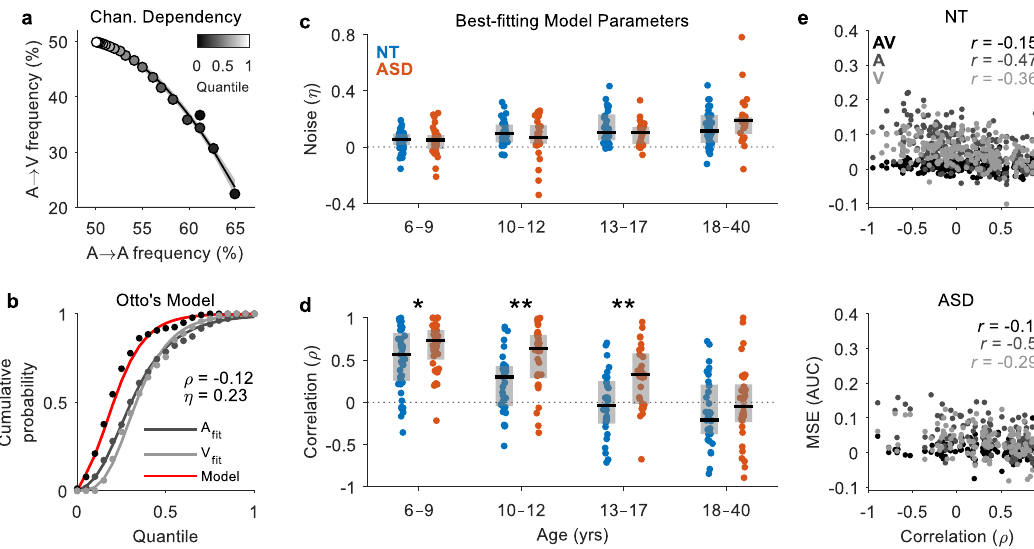
Fig. 7 Modelling channel dependency and RT variability. a Frequency of visual and auditory trials preceded by auditory trials in each quantile (i.e., switch vs. repeat trials). Quantiles are indicated by a grayscale, graduating from black (fastest quantile) to white (slowest quantile). Example data averaged over all NT adult participants. b CDFs were fi t to the unisensory RT data and used to predict empirical multisensory RT data via Otto ’ s context variant race model 64 . Free parameters ρ and η account for the correlation between RTs on different channels and increased RT variability or noise, respectively. Data from an example NT adult participant. c , d Best- fi tting model parameters ρ and η by diagnosis and age group. Boxplots indicate the median value (black line) and interquartile range (grey box). Each datapoint represents an individual participant (blue = NT, red = ASD). e Modality switch effect (MSE) as a function of model parameter ρ for NT (top panel) and ASD (bottom panel) participants. Each datapoint represents an individual participant (black = AV, dark grey = A, light grey = V).